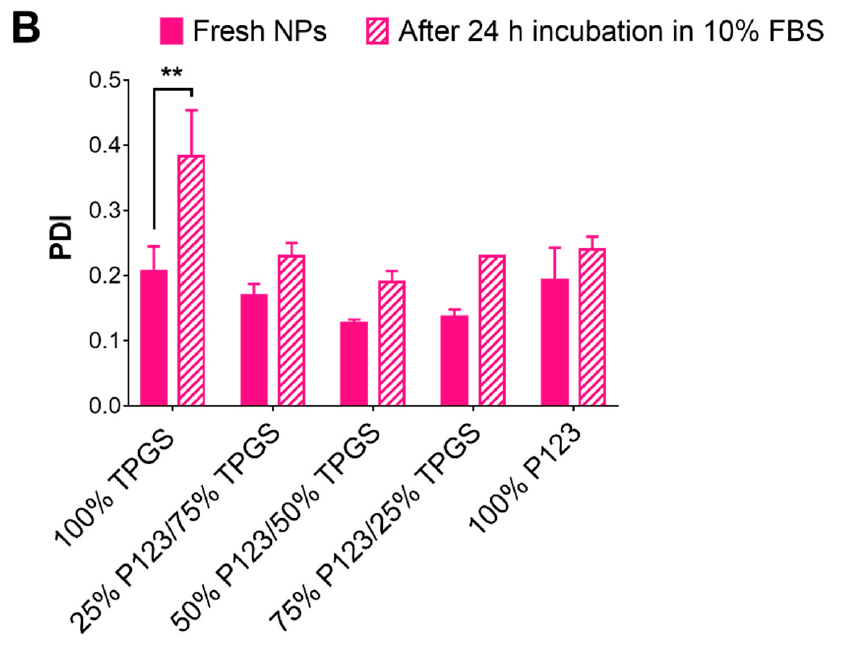
Figure 6. Change in ( A ) particle size and ( B ) PDI of R19-loaded NPs after 24 h incubation in cell culture medium supplemented with 10% FBS at 37 °C. Results are presented as the mean ± SD ( n = 3). * p < 0.05 and ** p < 0.01 based on two-way ANOVA followed by Sidak’s multiple comparison test.